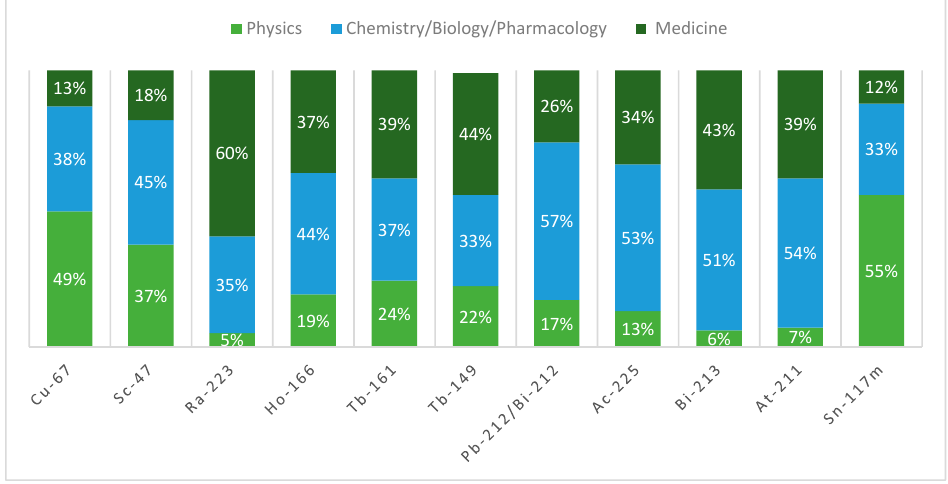
Figure 5. ERN macro-areas contribution (2008–2018).